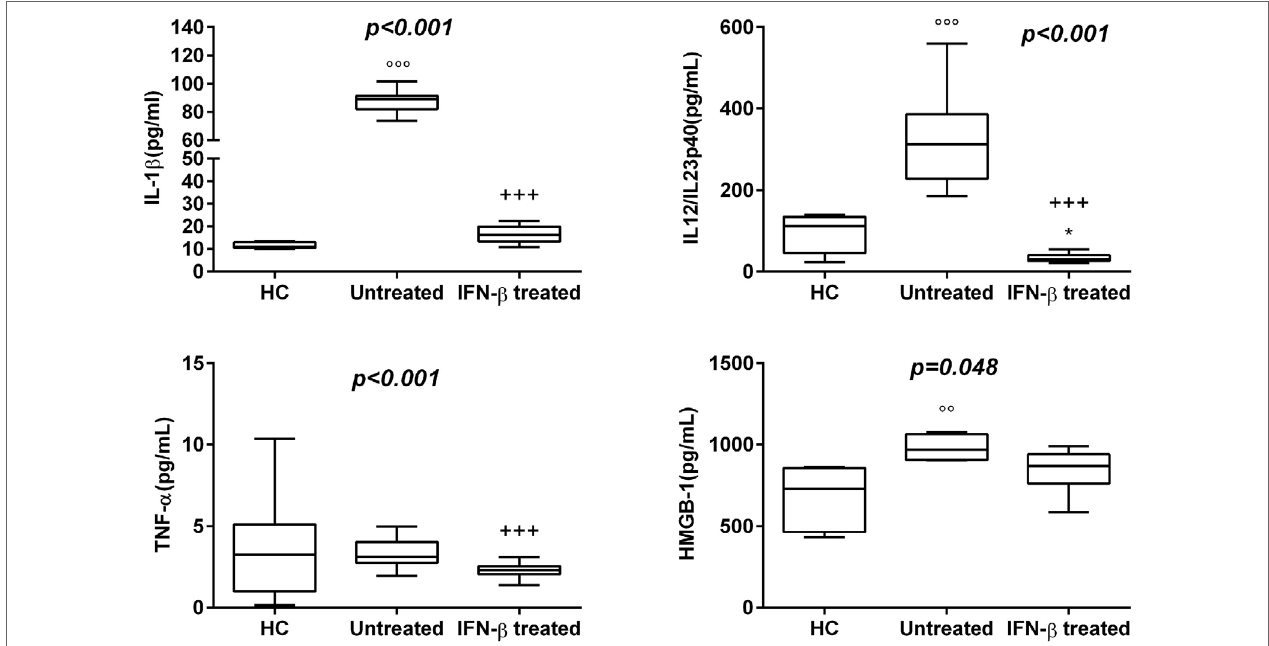
FigUre 1 | Box–whisker graphs of cytokine levels in the three study groups. Box–whisker plots show the 25th and 75th percentile range (box) with Tukey 95% confidence intervals (whiskers) and median values (transverse lines in the box). +++ p < 0.001 interferon (IFN)- β -treated vs untreated; ooo p < 0.001, oo p < 0.01 untreated vs healthy controls (HC); and * p < 0.05 IFN- β -treated vs HC of post hoc analysis. p -Value reported in figures are relative to Kruskal–Wallis H